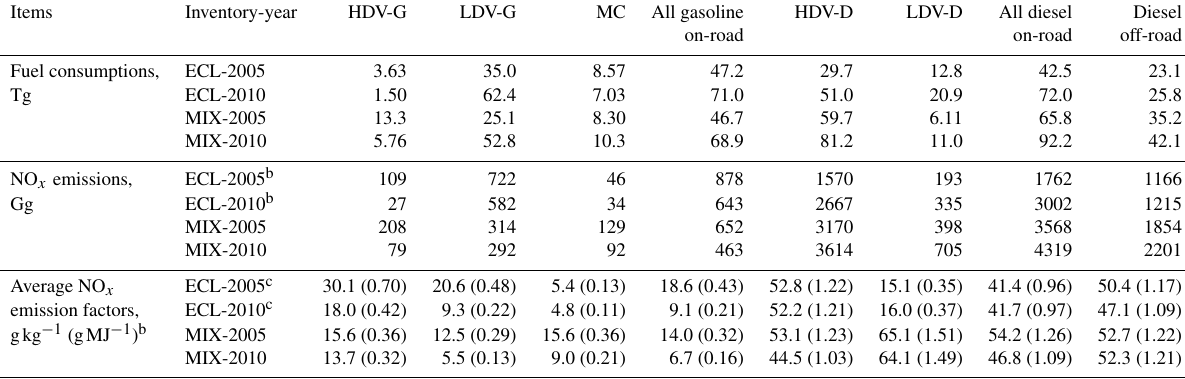
Table 3. Comparisons of activity, emissions and emission factors for the transport sector emission estimates of NO x a . Items Inventory-year HDV-G LDV-G Fuel